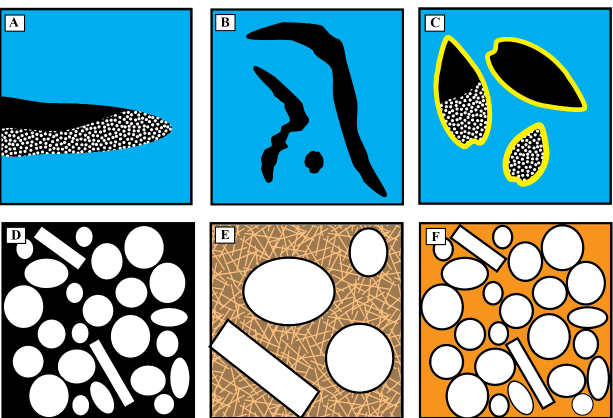
Figure 6. Schematic cartoons of the variability in porosity. ( A – C ) macro-porosity, from ( A ) Horizontal burrows ( Thalassinoides ), ( B ) variably shaped/oriented borings, ( C ) porosity within bivalves. ( D – F ) variability in micro-porosity, with end members of ( D ) no cement, inter-particle porosity well-developed, ( F ) up to 100% cement, no inter-particle porosity; ( E ) partially cemented with bladed and acicular aragonite, resulting in complex irregular inter-crystalline porosity. Note that blue areas of matrix in ( A – C ) are often well-cemented as in ( F ), while sediment within macro pores illustrated in ( A – C ), typically have porosity as in ( D , E ), with thin well cemented laminae ( F ) (Figure 4e). Additionally, burrows often surrounded/demarcated by pore-occluding cement, as in ( F ).